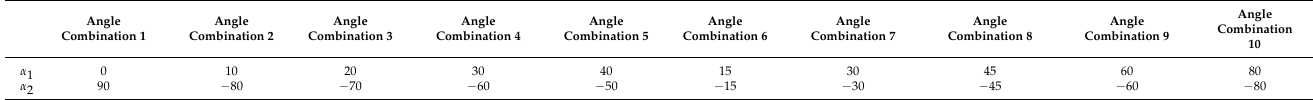
Table 2. Distribution of double FBG pinch angles.